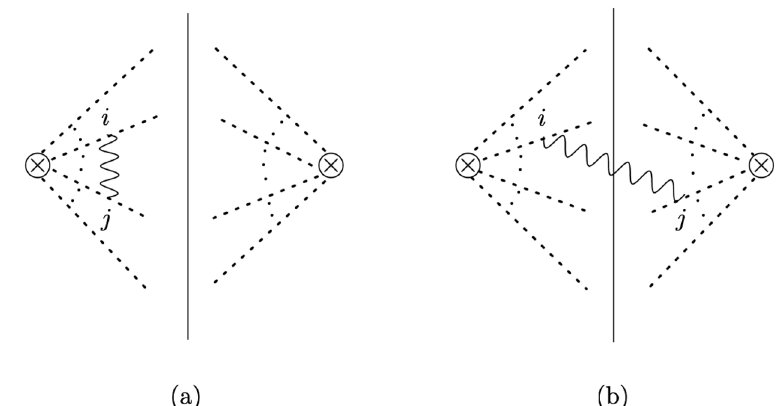
Figure 1 . Feynman diagrams for the emission of a soft gauge boson from the soft Wilson lines Y or Y . The vertical lines are the final-state cut. (a) The virtual contribution, (b) the real contribution. The gauge bosons attached to the same i do not contribute because n 2 contractions with different i and j should be